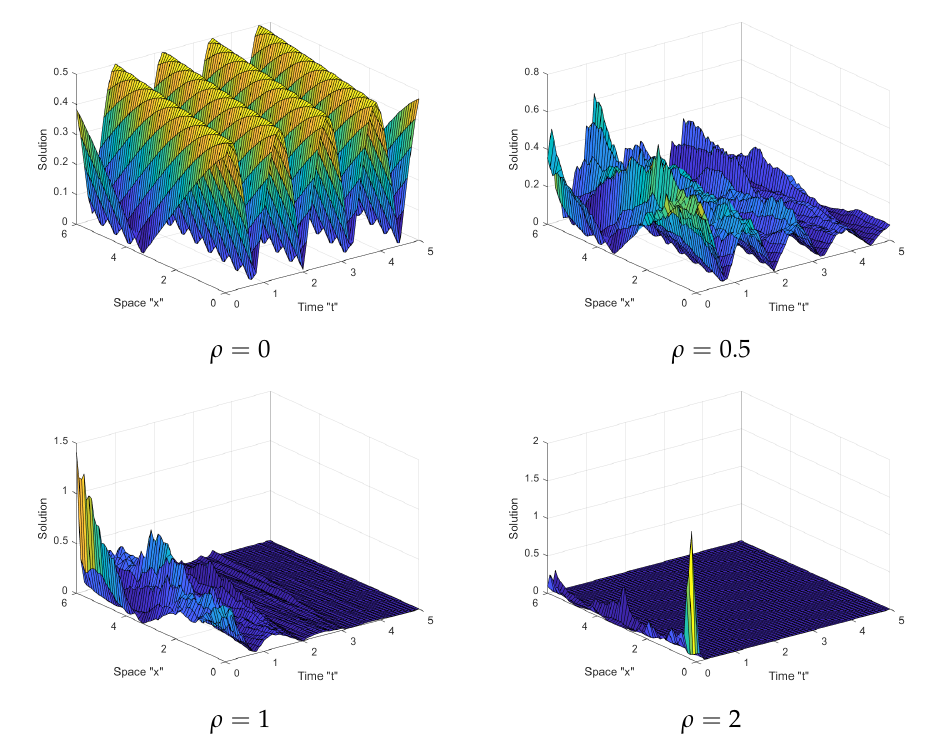
Figure 1. Profile picture of | U | given in (14) in three dimension for α = 1 and θ 3 = −